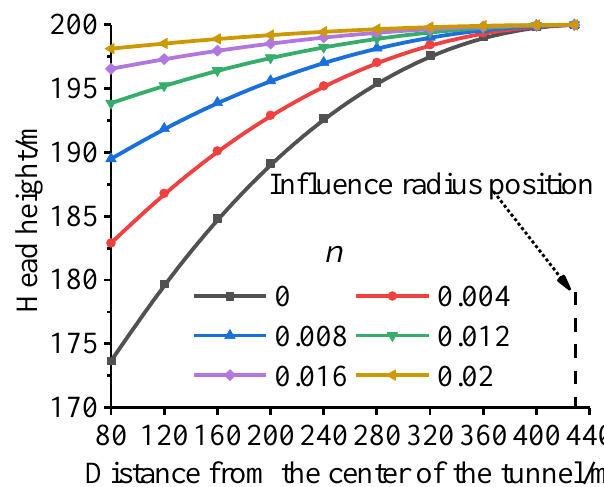
Figure 6. Water head height curve of ordinary surrounding rock section.